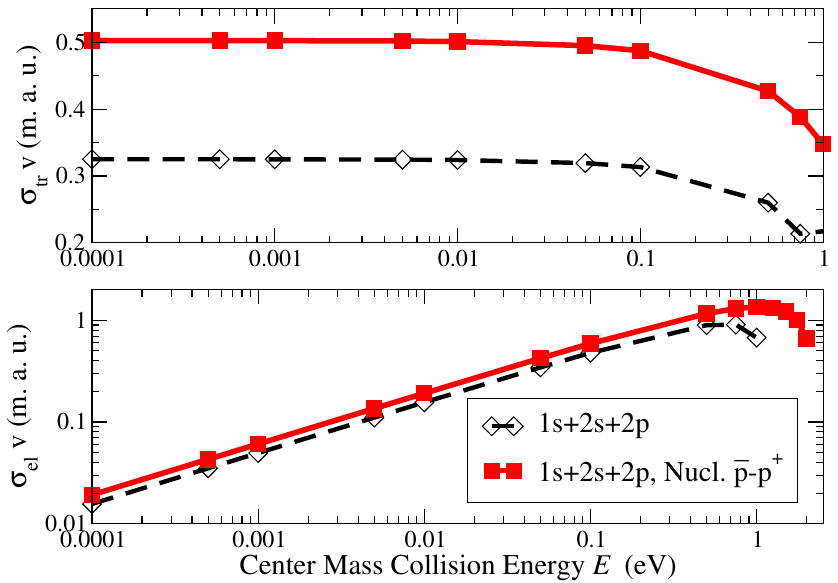
Figure 5. Upper plot: the reaction rate, i.e., integral cross sections σ tr of the reaction (3) multiplied by the collision velocity v with and without inclusion of the ¯p-p strong interaction for comparison purposes. Only the 1 s + 2 s + 2 p MCCA method is used in these calculations. Lower plot: corresponding results as on the top plot, but for the elastic scattering cross section of the process (3), σ el , multiplied by the collision velocity v = v c . m .